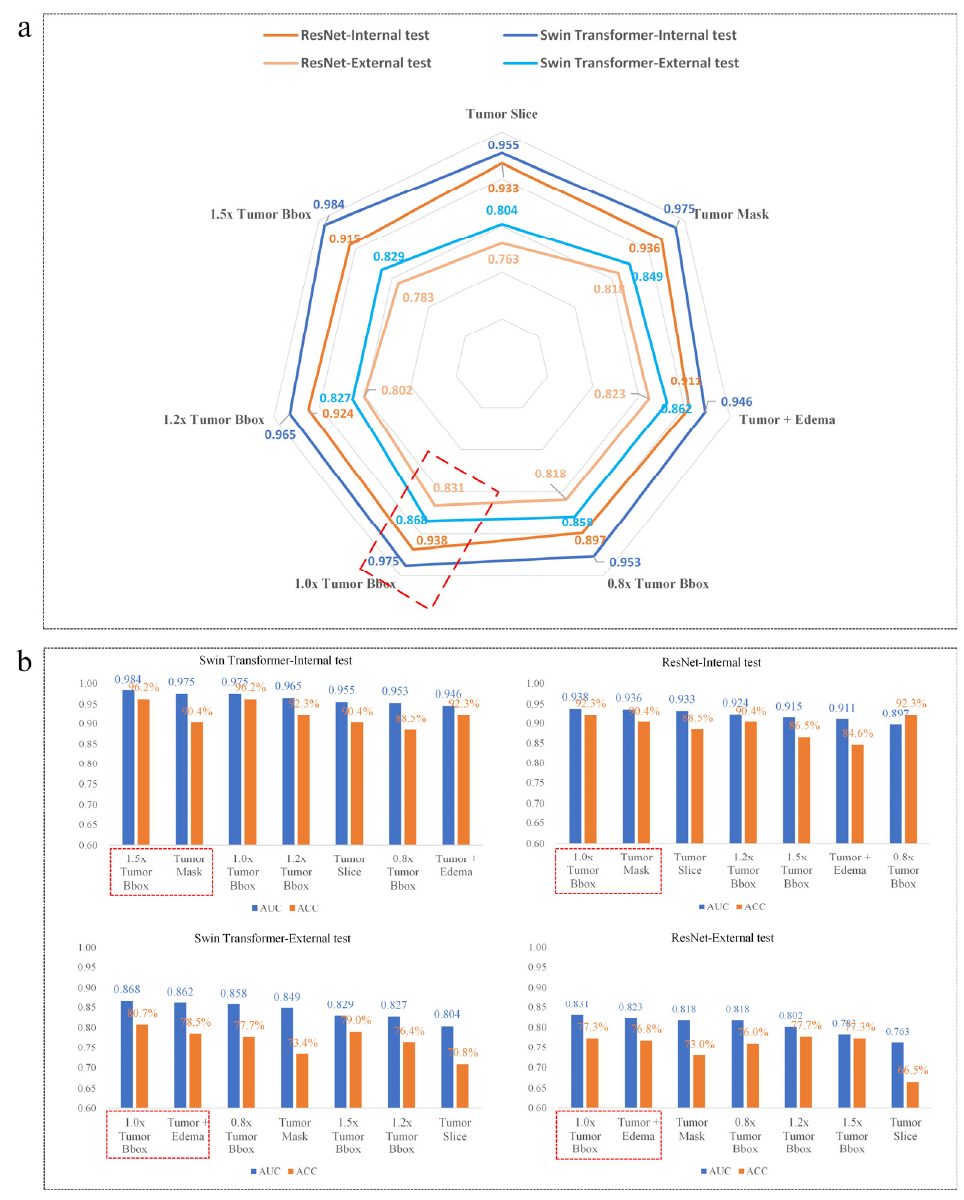
Figure 5. Visualization of model performance. ( a ) Radar map of the model AUC. When the same input images were used, the transformer models obtained higher AUC than the corresponding ResNet models. ( b ) Histogram of the model AUC and accuracy (ACC). All the histogram was presented in the order of model AUC from highest to lowest. Using 1.0 × Tumor Bbox images as inputs, both the Swin Transformer and ResNet models achieved the best performance on the external